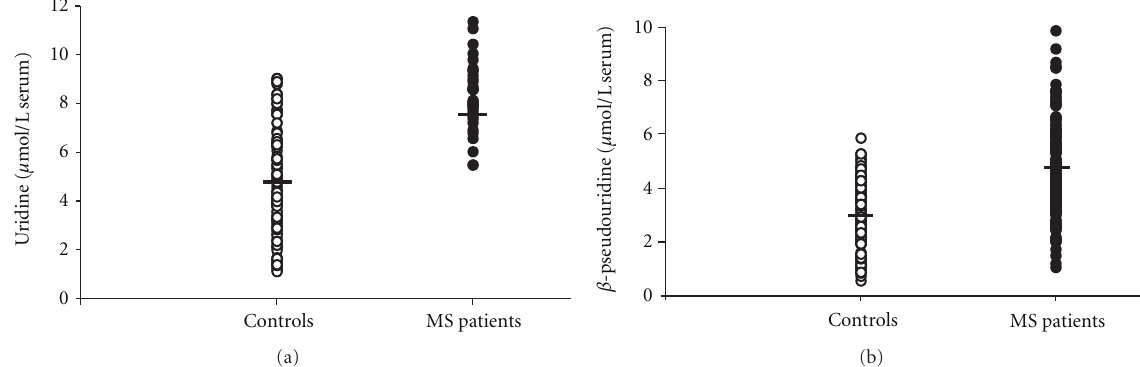
Figure 3: Scatter plot showing the concentrations of uridine (a) and β -pseudouridine (b) recorded in serum of 163 controls healthy and 170MS patients. Horizontal bars indicate the mean values calculated in the two groups.